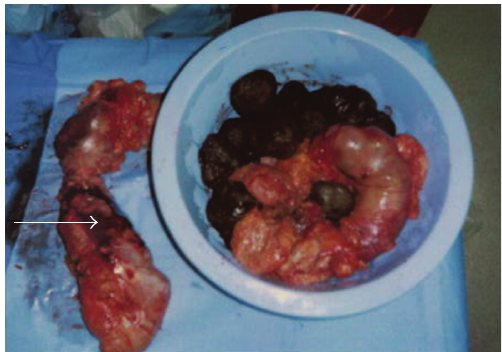
Figure 1: CT scan of the abdomen with free air (star) and colonic wall thickening (arrow).